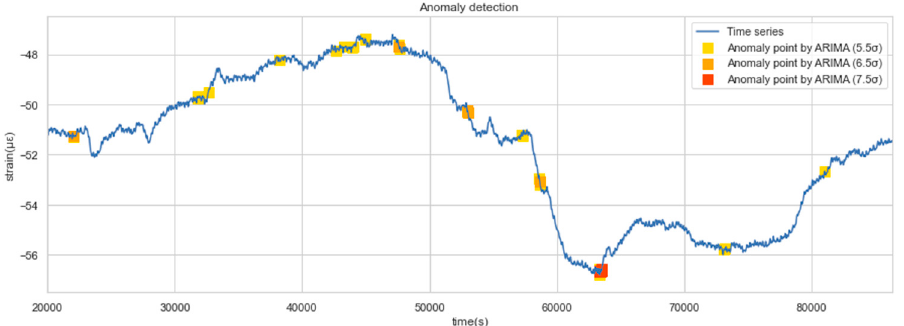
Figure 15. Anomalies of different levels.